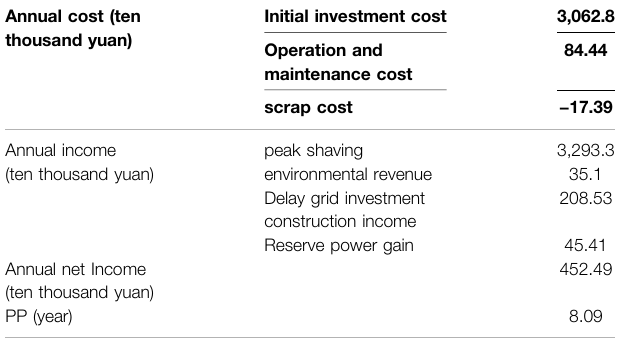
TABLE 6 | Annual cost and bene fi t of “ idle time reuse ” control